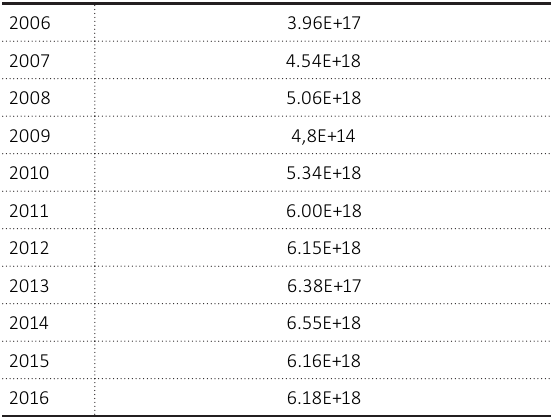
Table 4. World GDP in